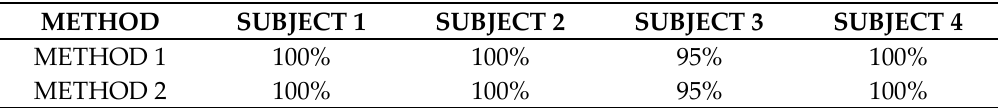
Table 1. Accuracy of the proposed methods for test